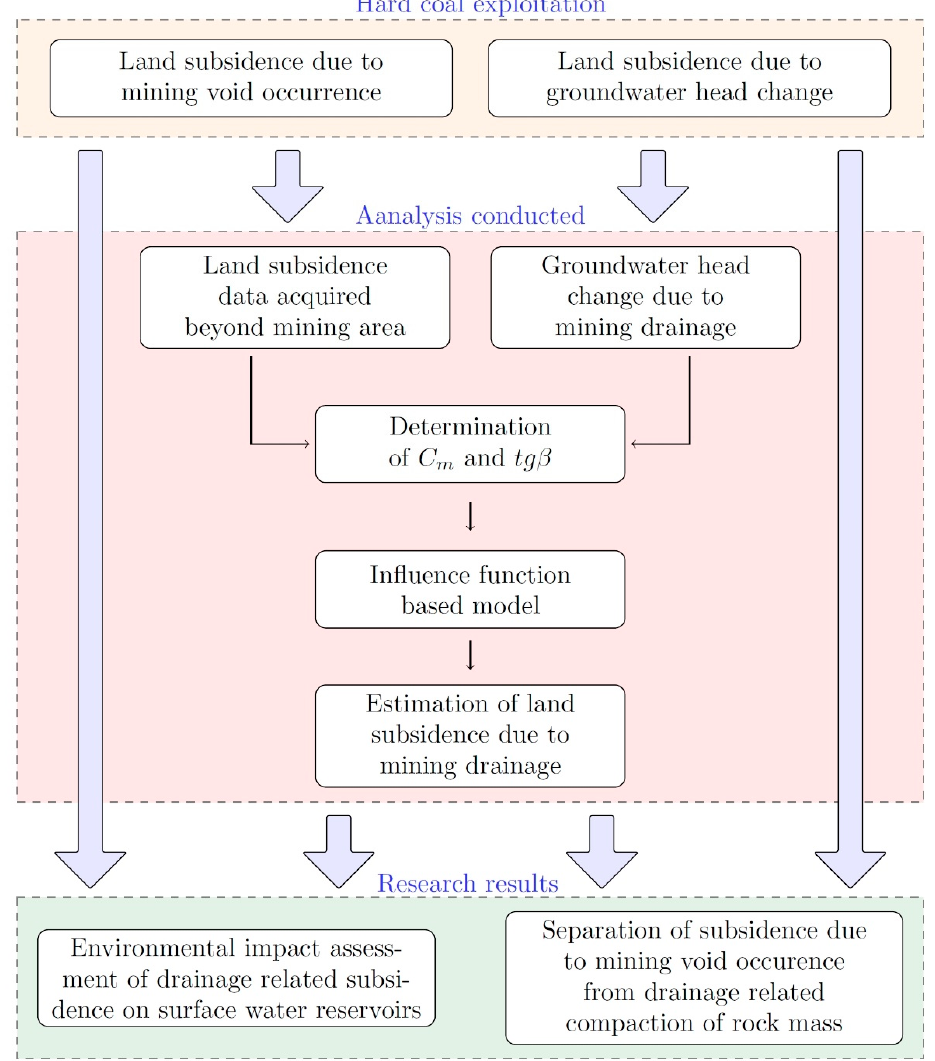
Figure 6. Flowchart of the methodology used in the study presented.